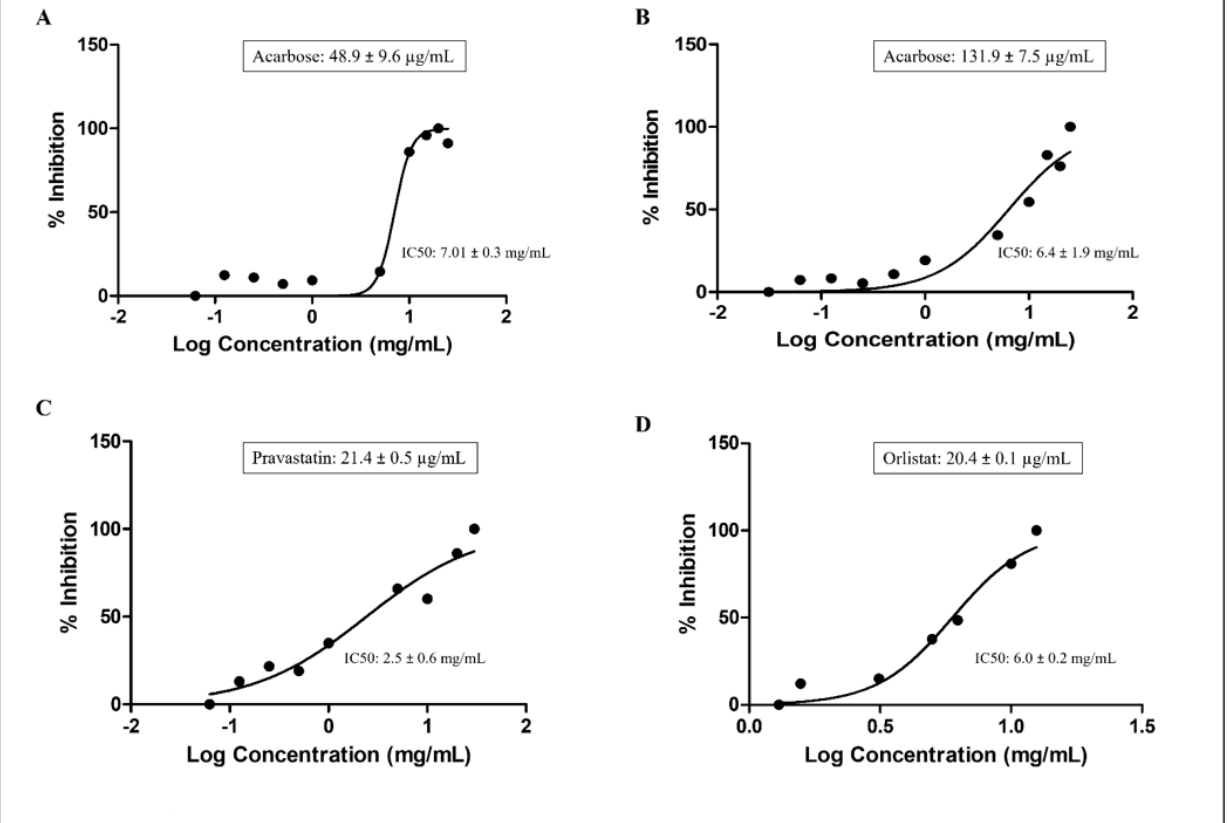
Figure 4. Enzyme inhibition activities and calculated IC50 values of P. domestica subsp. syriaca fruit pulp extract. α‐ amylases inhibition ( A ), α‐ glucosidase inhibition ( B ), HMG CoA reductase inhibition ( C ), Pancreatic lipase inhibition ( D ). Data expressed as mean ± SD. The IC50 values of the fruit extract against each enzyme were calculated using nonlinear regression analysis.